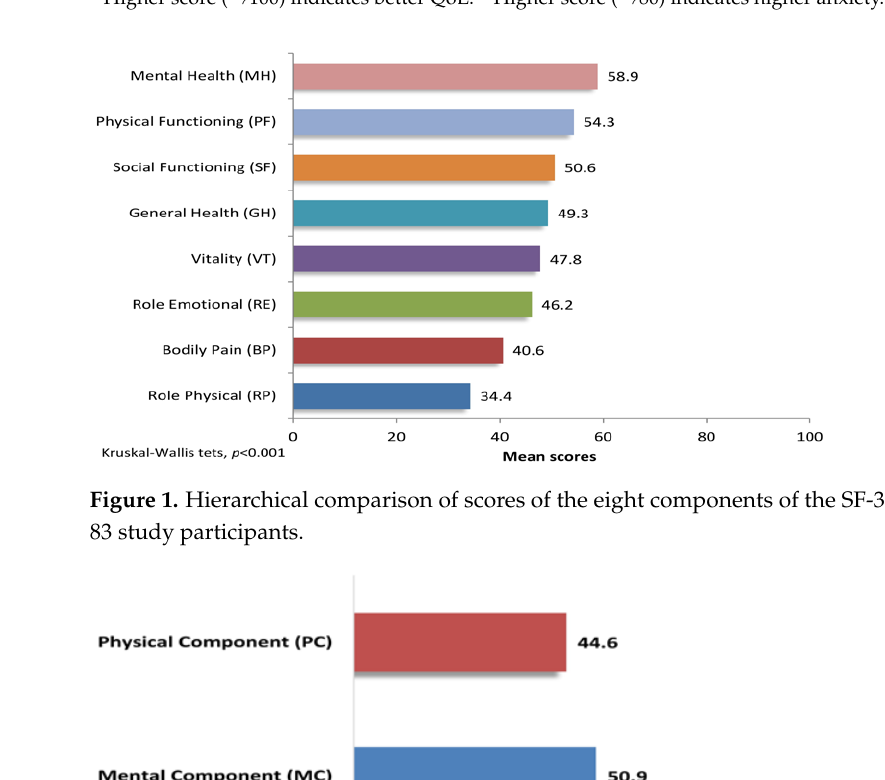
Figure 2. Comparison of scores of the two main components of the SF-36 QoL scale for the 83 study participants.